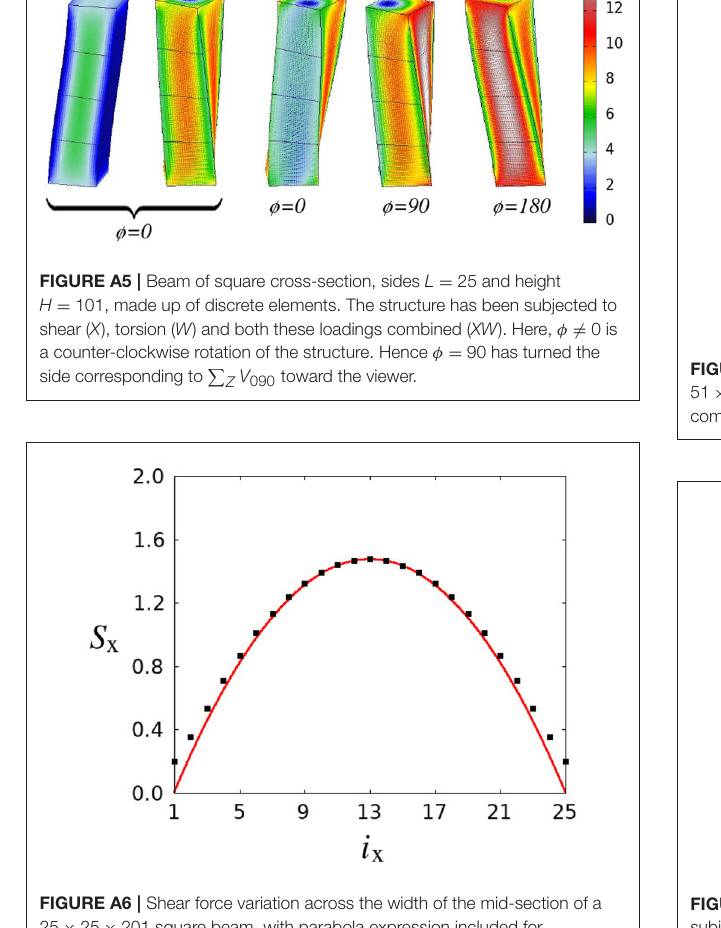
of each “beam.” If a “beam” is axially weak we also